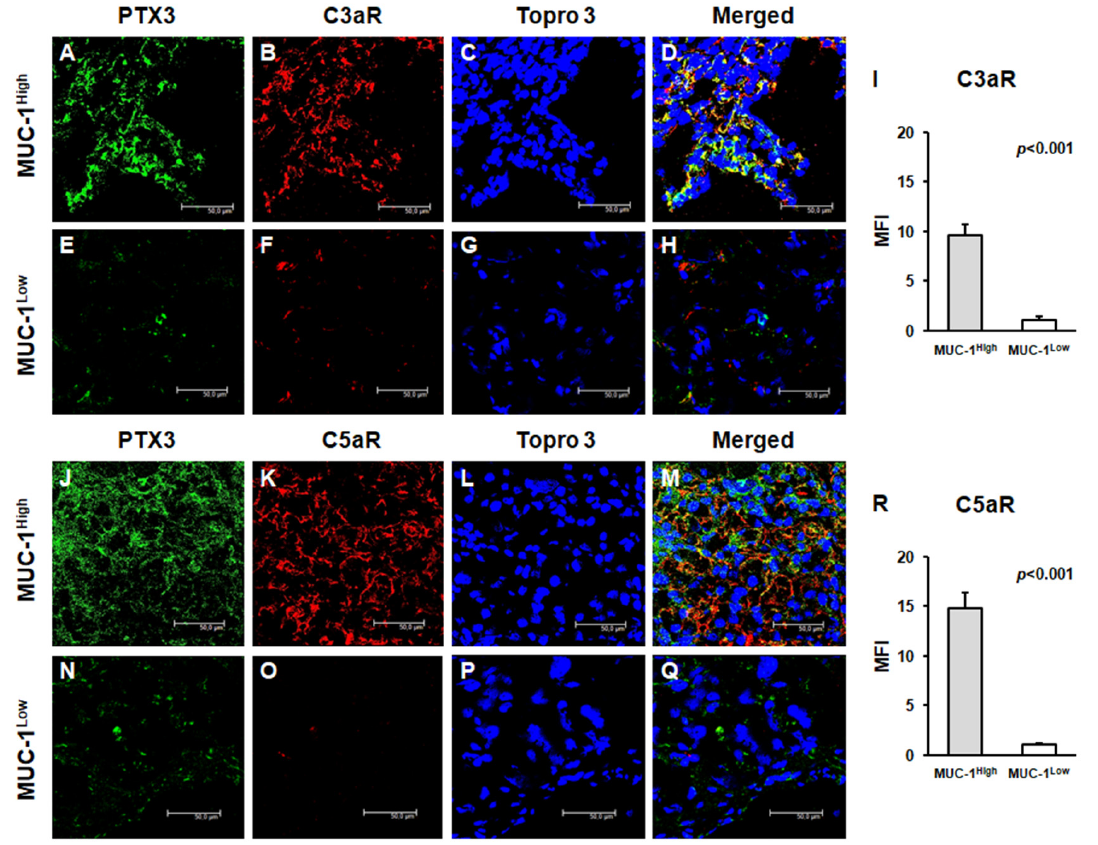
Figure 4. Expression of anaphylatoxin receptors C3aR and C5aR and their colocalization with PTX3 in neoplastic renal tissues from MUC1 H ccRCC ( A – H ) and MUC1 L ccRCC ( J – Q ) by confocal microscopy and quantification of specific fluorescence ( I , R ).